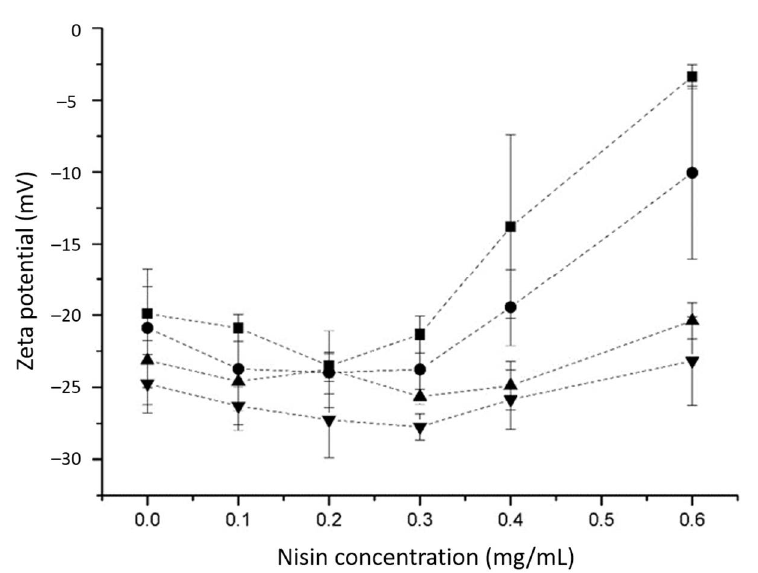
Figure 1. Zeta potential of nisin-loaded ulvan particles at different pH values depending on nisin concentration; - ■ -, pH 4.0; - ● -, pH 5.0; - ▲ -, pH 6.0; - -, pH 7.0. The final concentration of ulvan was equal to 0.4 mg/mL. Data are shown as mean values ± standard deviations of three parallel measurements.